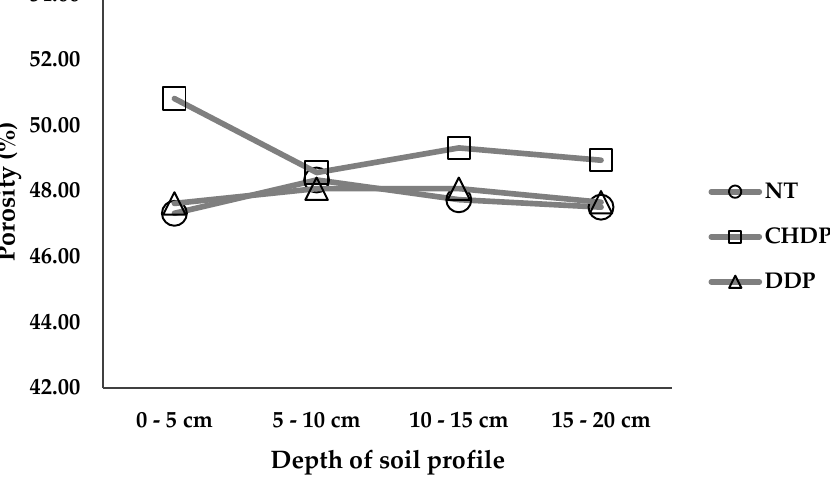
Figure 7. Total porosity in the soil profile at intervals of 5 cm at the beginning of the experiment in 2013.